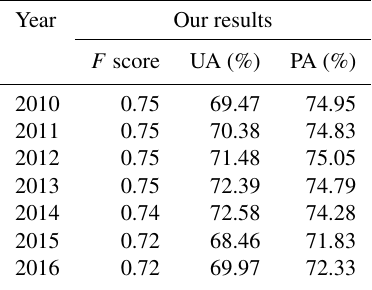
Table 4. The oil palm accuracy in Indonesia from 2010–2016. UA: user’s accuracy. PA: producer’s